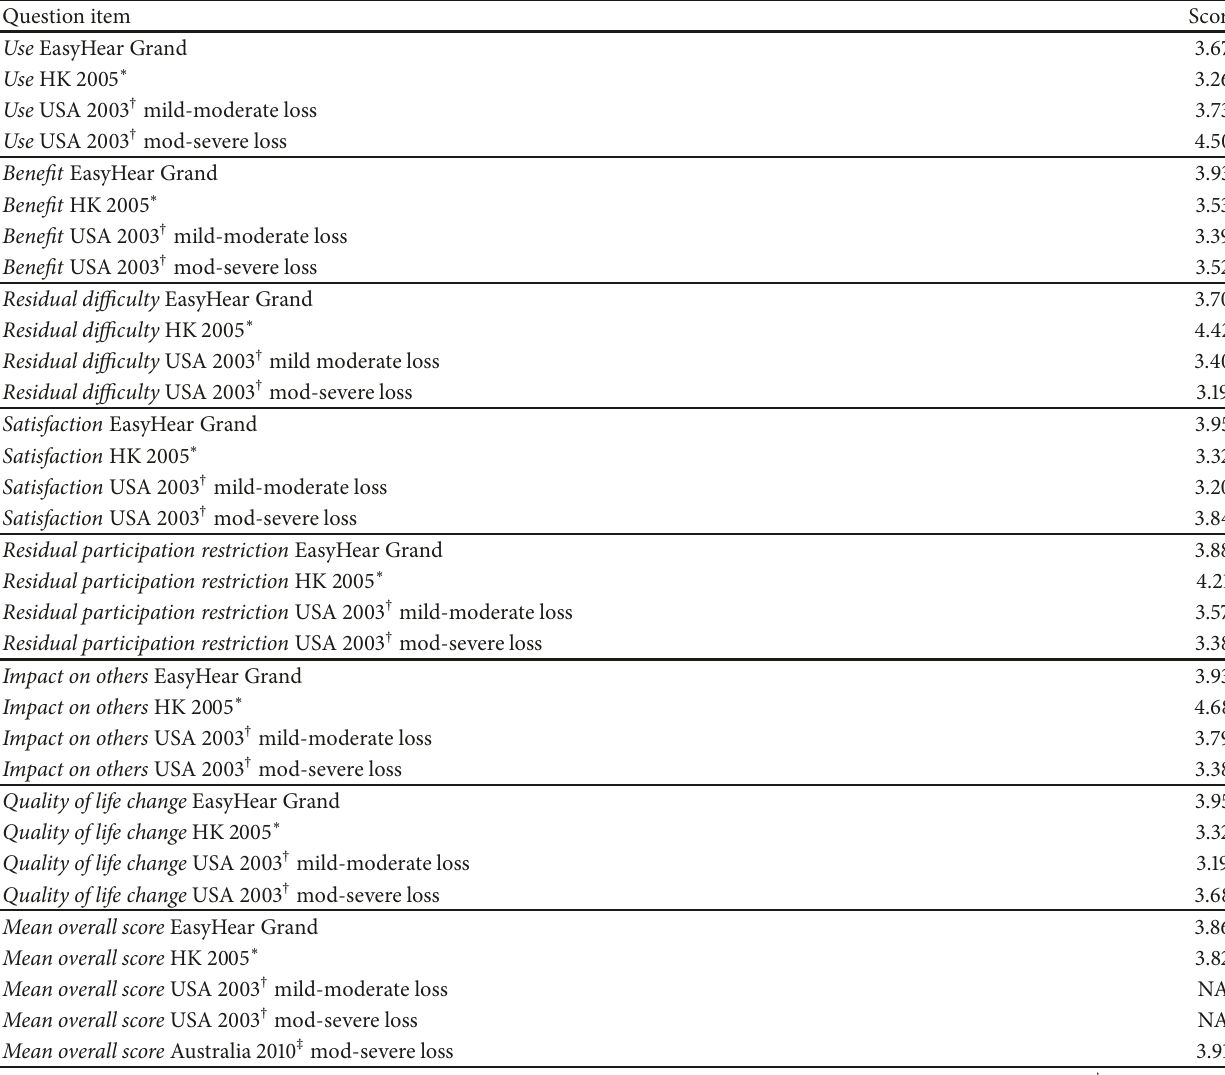
Table 8: IOI-HA scores for all question items for EasyHear Grand (Visit 3) and previous